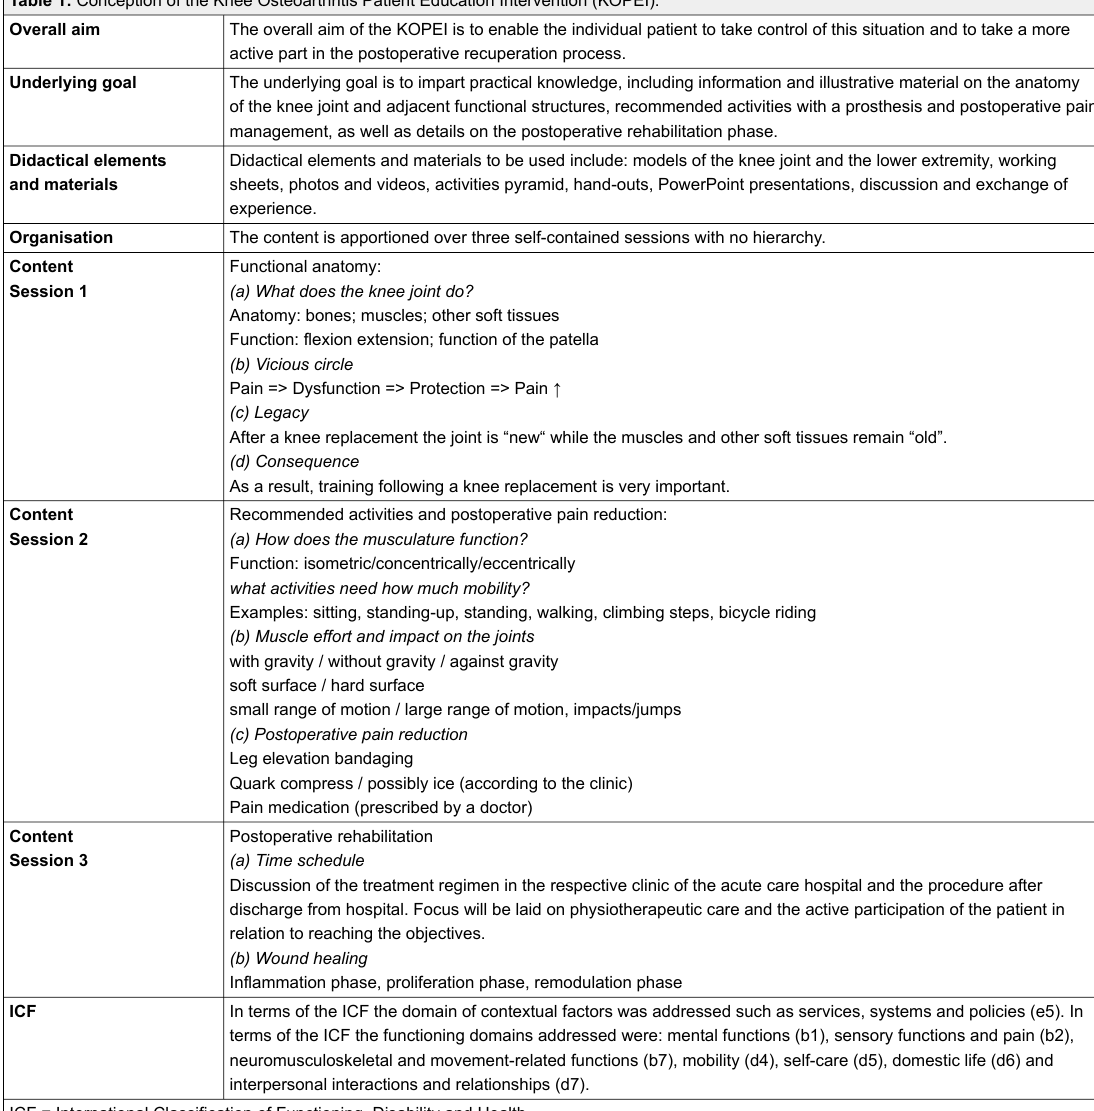
Table 1: Conception of the Knee Osteoarthritis Patient Education Intervention (KOPEI). Overall